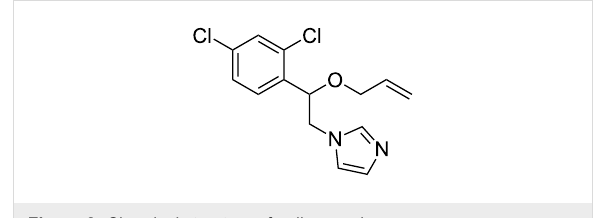
Figure 2: Chemical structure of enilconazole.